Question: In one sentence, what is this figure communicating?
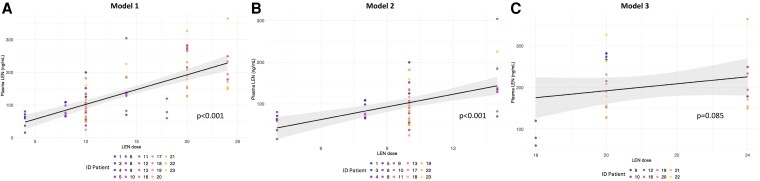
Answer: Linear mixed-effects models, before adjusting for covariates, showing the relationship between LEN dose ( x -axis) and plasma LEN ( y -axis): (A) Model 1 (plasma samples from all patients); (B) Model 2 (plasma samples from patients treated with LEN <18 mg); (C) Model 3 (plasma samples from patients treated with LEN ≥18). During follow-up, lenvatinib doses were both reduced and escalated; thus, plasma samples from the same patient may correspond to either low (<18 mg) or high (≥18 mg) dose levels depending on the sampling time point. Accordingly, some patients contributed samples to both dose groups.